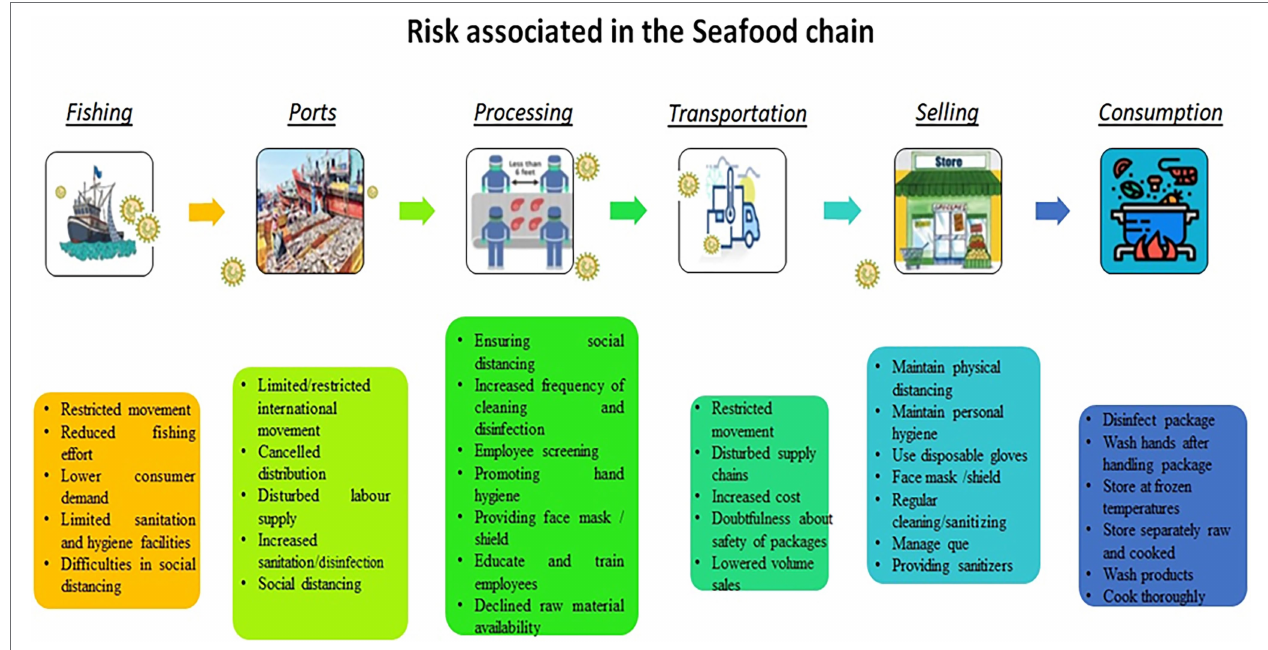
FIGURE 1 | Risks associated in the seafood chain.